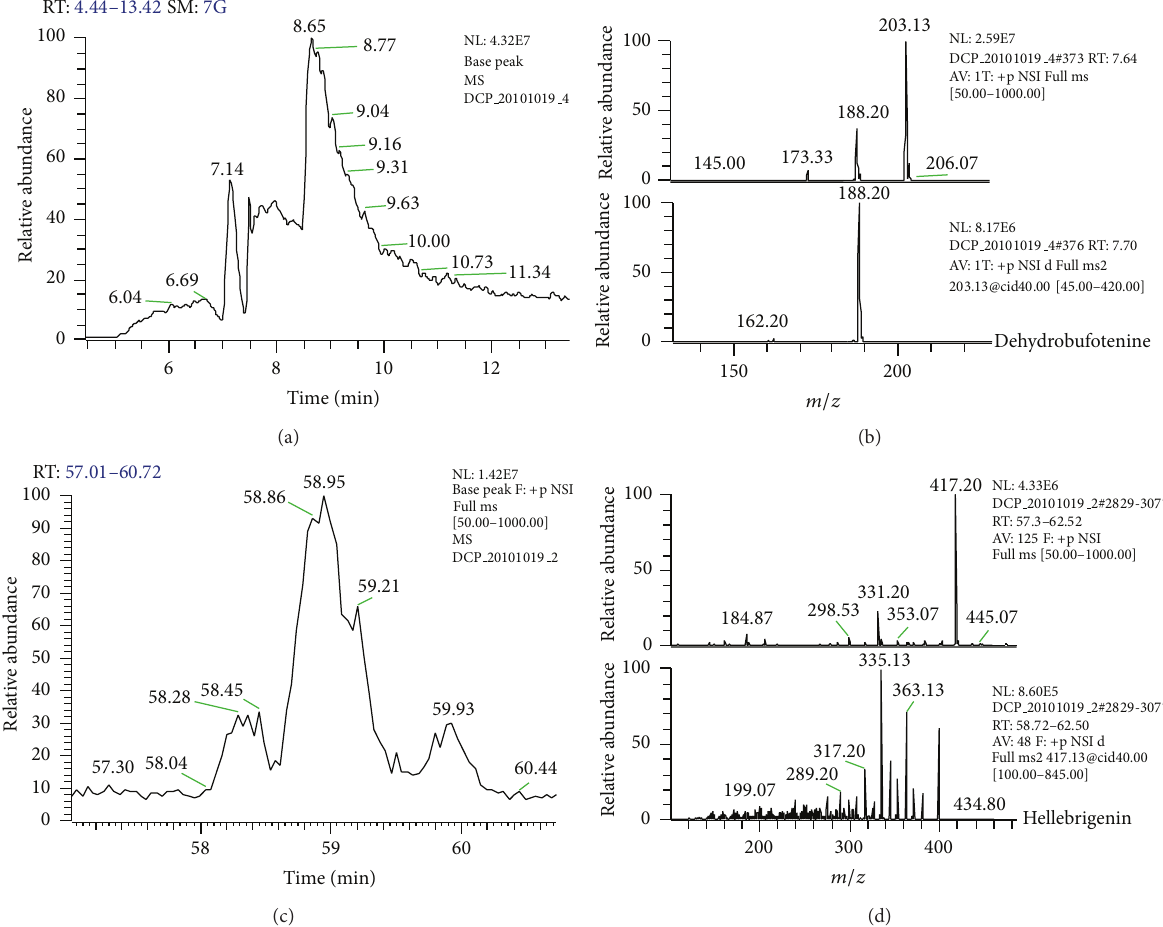
Figure 3: Detailed view of on-line LC-MS/MS analyses performed for the analyses of the skin secretion of R. schneideri ((a) zoomed TIC chromatogram and (b) MS and MS 2 profiles) and R. jimi ((c) zoomed TIC chromatogram and (d) MS and MS 2 profiles). The molecules could be identified as being dehydrobufotenine and hellebrigenin based on the daughter ions and published